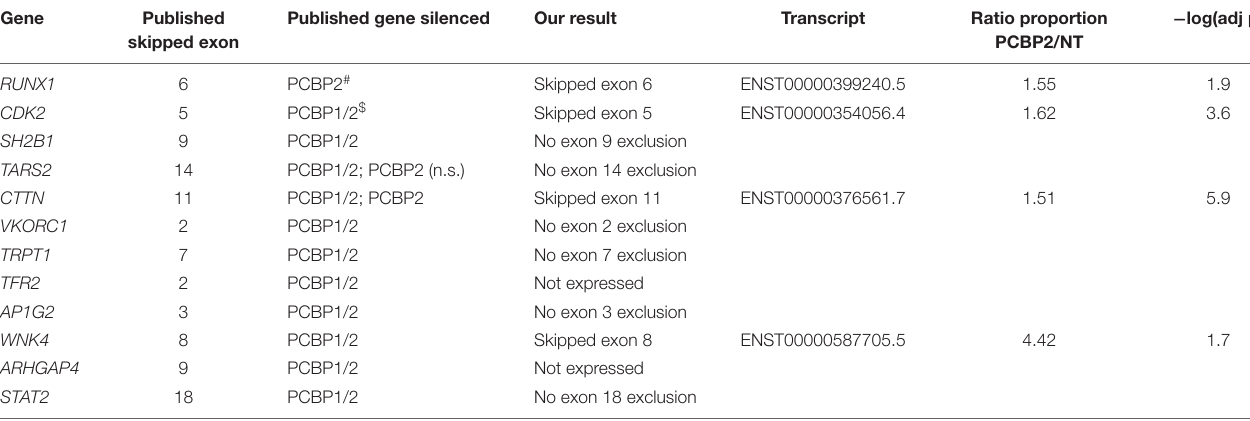
TABLE 3 | Comparison between this study and published